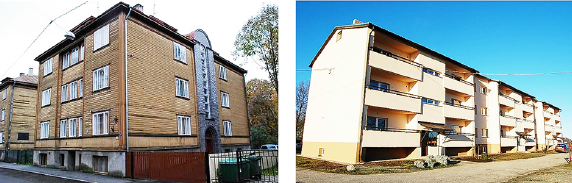
Table 1. Thermal conductivity l , W/(m·K) of the materials used Thermal Material conductivity l , W/(m∙K) Polyurethane foam (PU) 0.024 Additional insulation (mineral wool/ EPS) 0.040 Phenolic foam (based on phenolic resin) 0.043 Mineral wool of exist. building envelope 0.070 Rubber foam, mastics 0.10 Sawdust 0.10 Wood